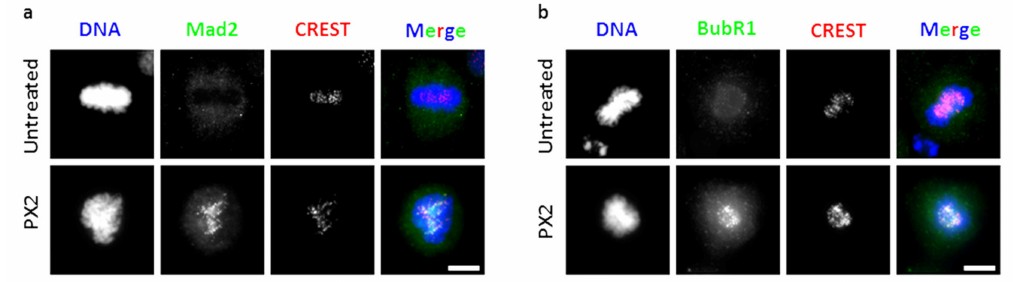
Figure 5. Treatment with pyranoxanthone 2 (PX2) triggers the spindle assembly checkpoint. Immunofluorescence staining using antibodies against ( a ) Mad2 (green), ( b ) BubR1 (green), CREST (red) and DAPI (blue) in untreated and PX2-treated cells, as indicated. In untreated cells, Mad2 and BubR1 is not located in kinetochores, consistent with their normal localization pattern. In PX2-treated cells (bottom panel), these proteins are present in all mitotic cells, indicating spindle assembly checkpoint activation. Bar, 5 µ m.